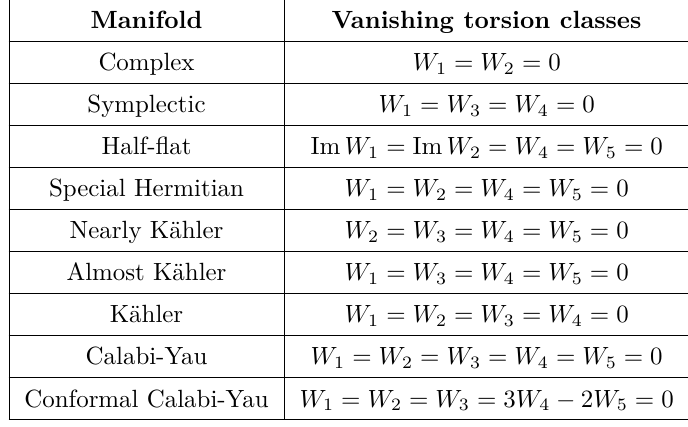
Table 1 . Vanishing torsion classes in special SU(3) structure manifolds